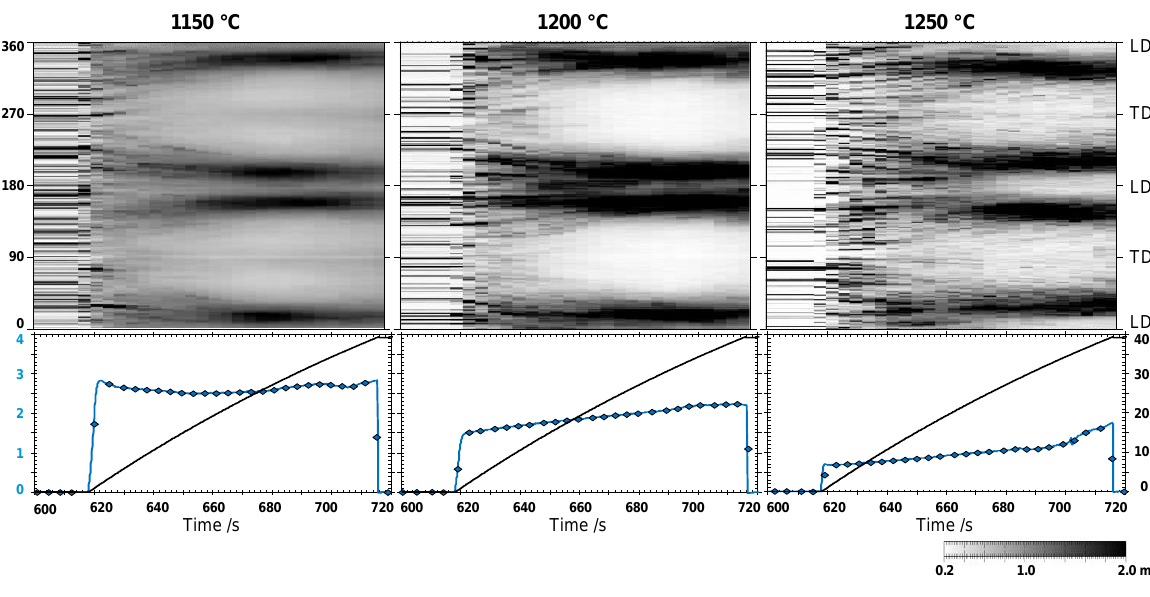
Figure 5. Azimuth angle vs. time diagrams for the α-002 reflection during hot compression at 1150 °C, 1200 °C, and 1250 °C using a compression rate of 5 × 10 −3 ·s −1 . The azimuthal orientation distribution is coded using a greyscale. The process parameters of force and deformation are indicated below the diagrams. LD: Load direction. TD: Transverse